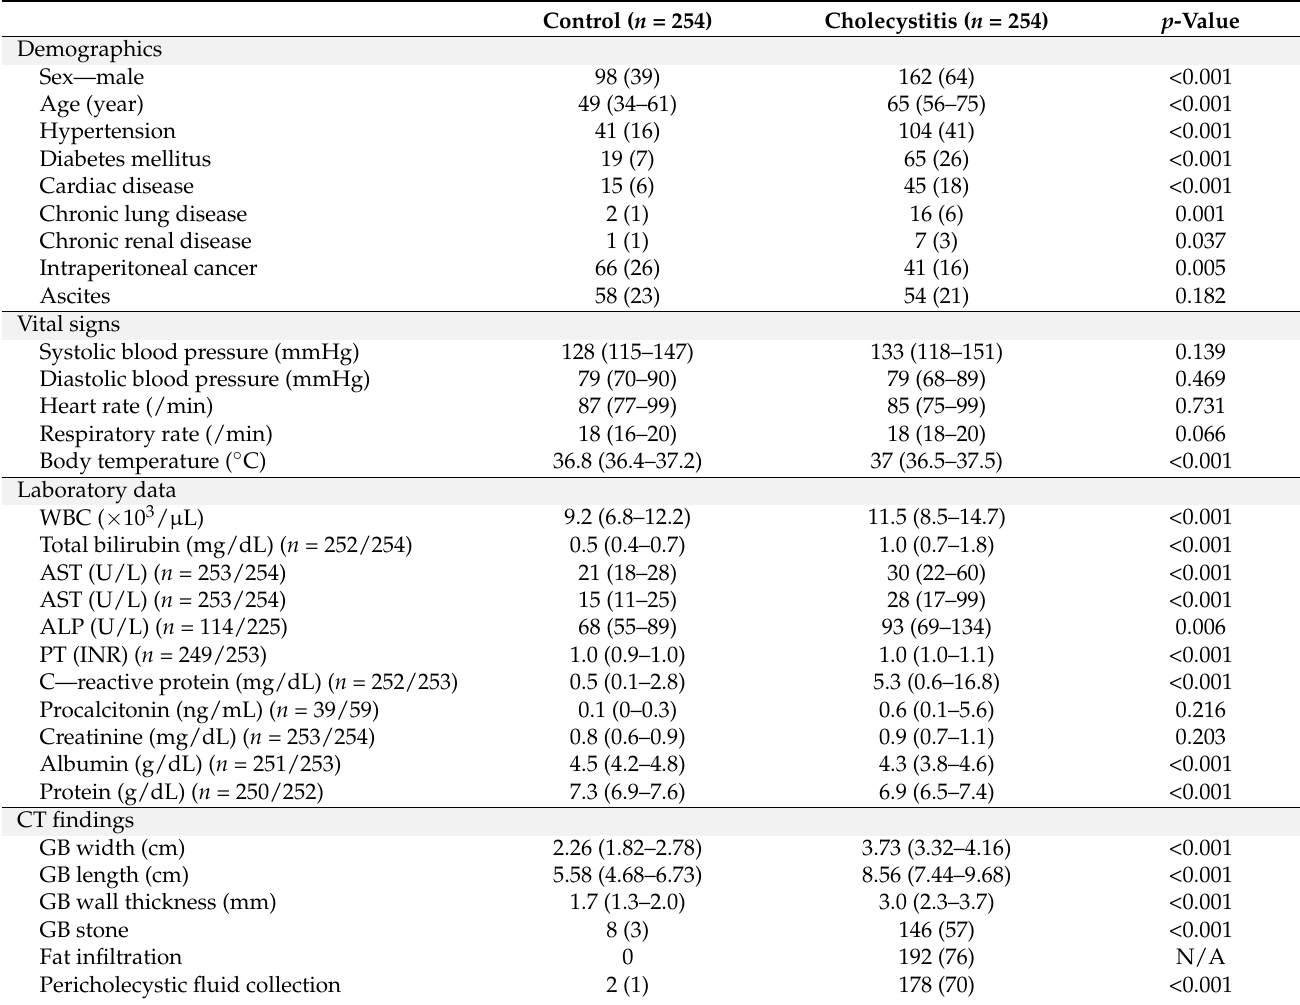
Table 1. Patient characteristics, laboratory data, and computed tomography findings.